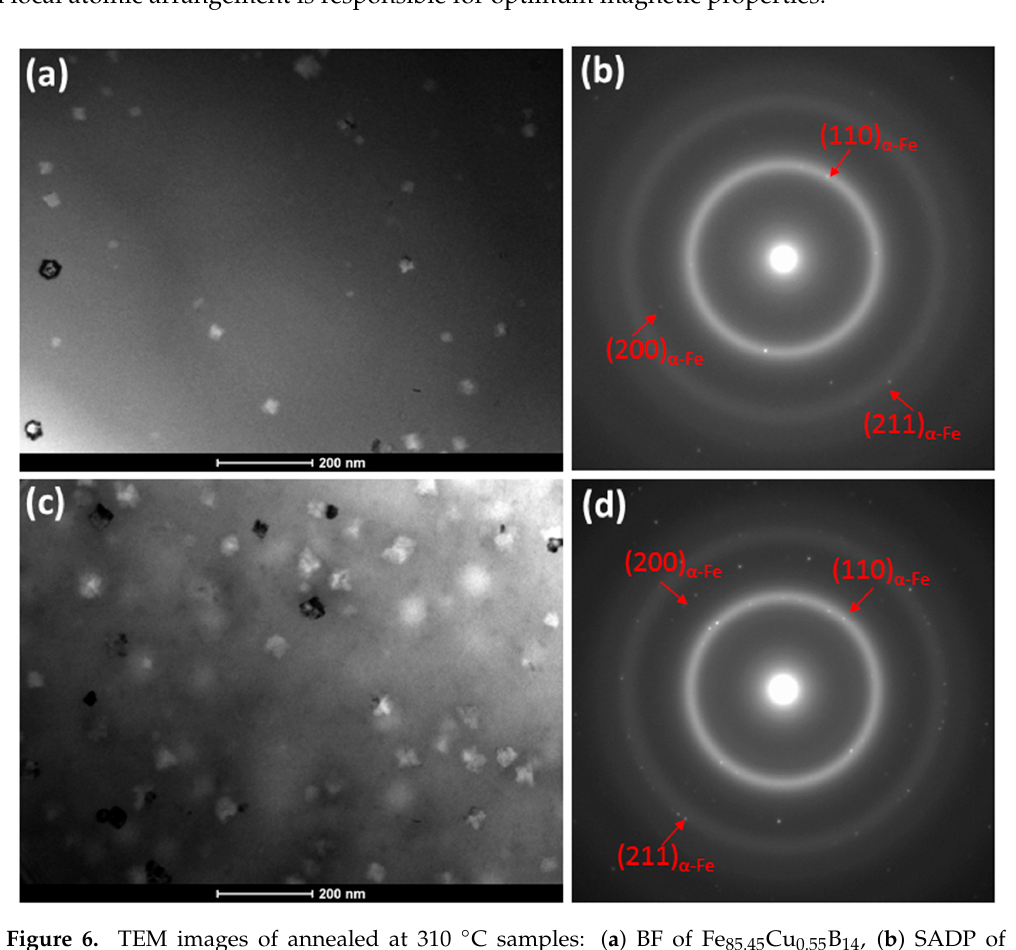
Figure 6. TEM images of annealed at 310 °C samples: ( a ) BF of Fe 85.45 Cu 0.55 B 14 , ( b ) SADP of Fe 85.45 Cu 0.55 B 14 at 310 °C, ( c ) BF of Fe 75.45 Co 10 Cu 0.55 B 14 , ( d ) SADP of Fe 75.45 Co 10 Cu 0.55 B 14 at 310 °C.